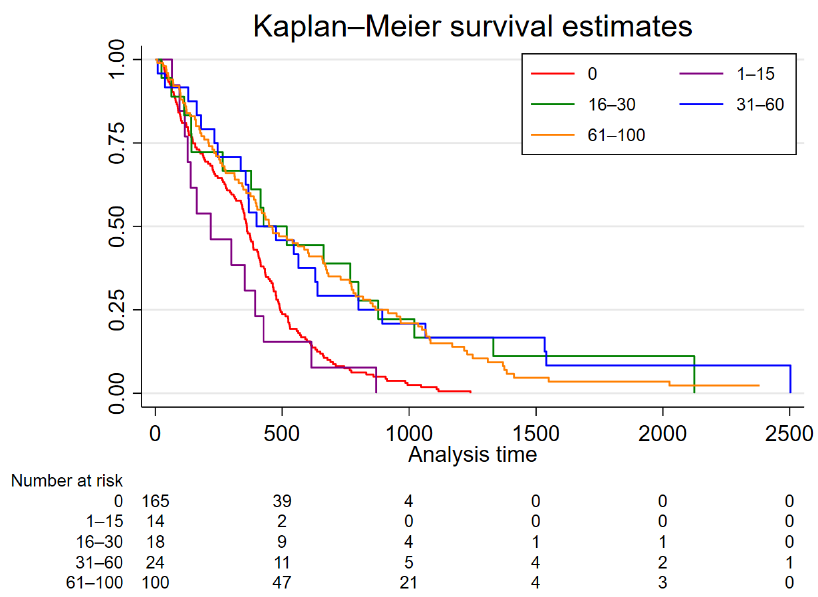
Figure 2. Kaplan-Meier analysis stratified for MGMT promoter methylation status. Patients with ≥ 16% methylation of the MGMT promoter region displayed significantly longer survival compared with patients with unmethylated tumors. Survival of patients with 1–15% methylation was similar to that of patients with unmethylated MGMT promotors. Table 2. Survival according to quantitative MGMT promoter methylation status.